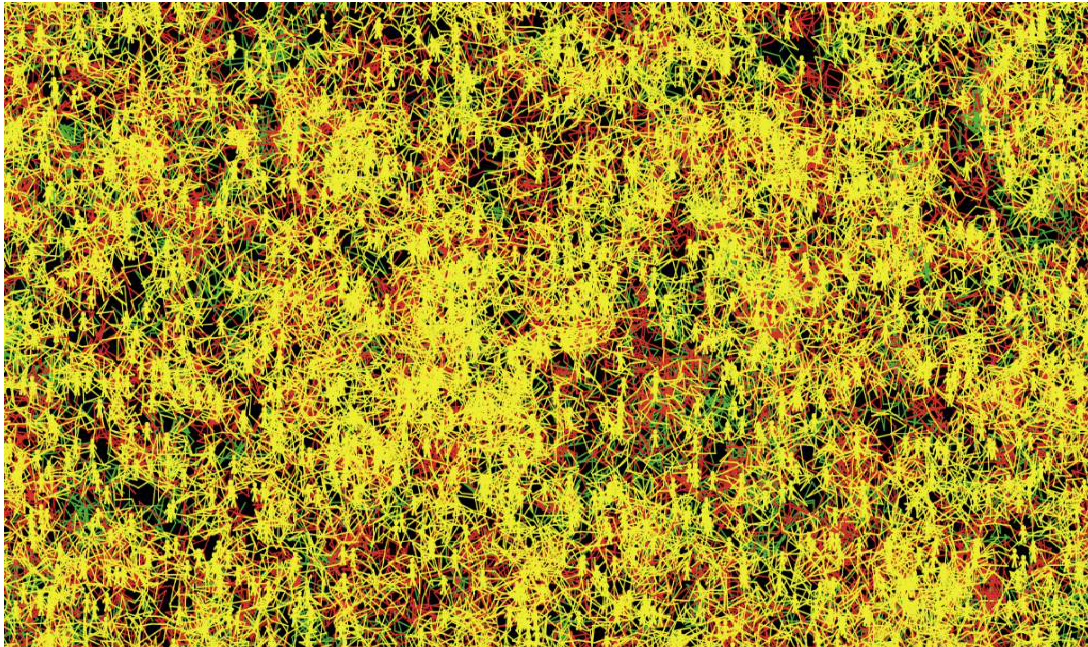
Figure 9. Movement patterns in the first experiment at 0% social distancing.